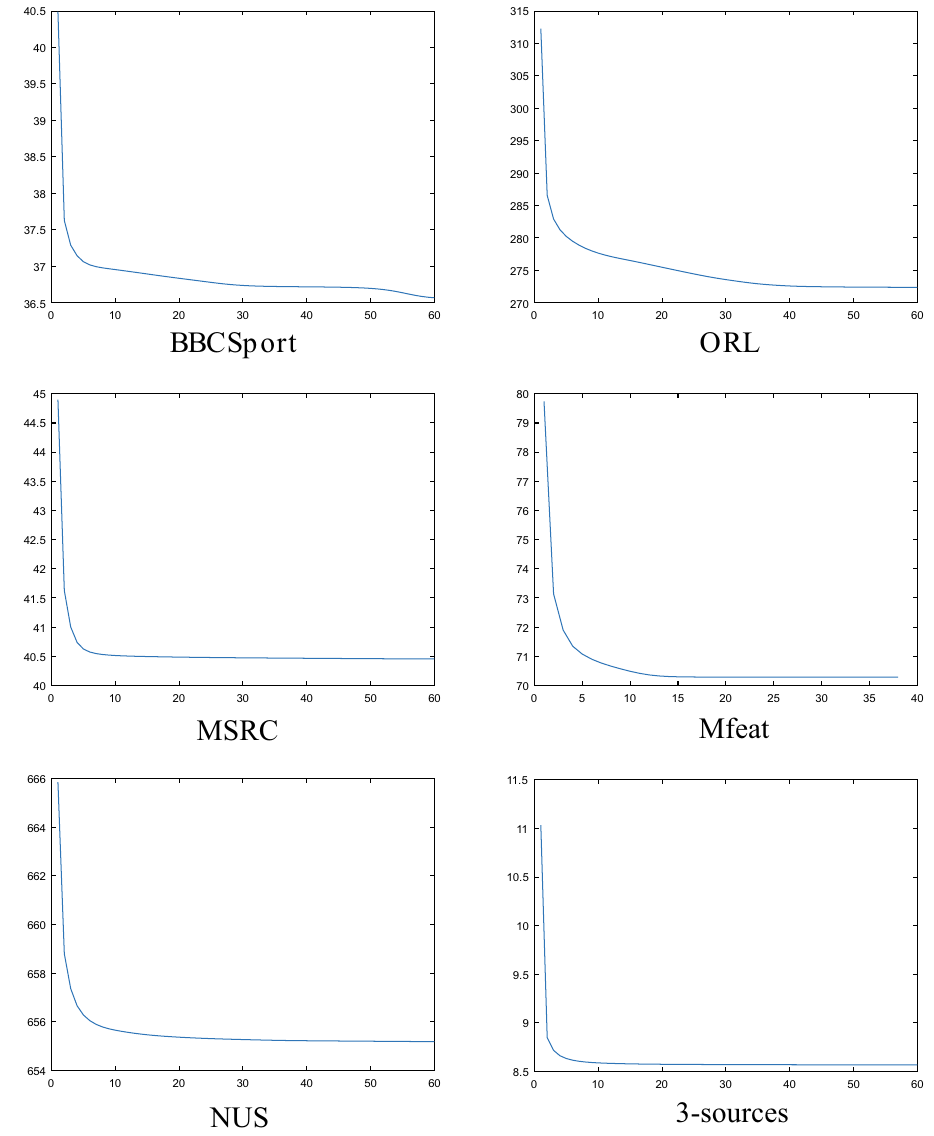
Figure 6. The change in the value of the objective function of algorithm 2.